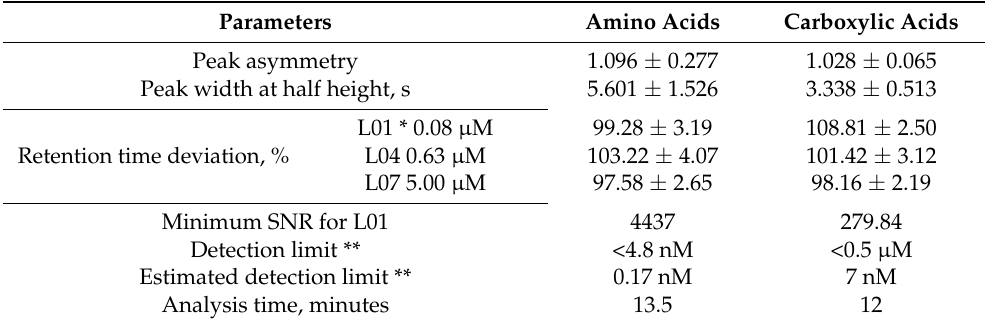
Table 11. The main characteristics of the detection of signals of amino and carboxylic acids by the developed chromato-mass-spectrometric methods, based on the use of a mass analyzer with a triple